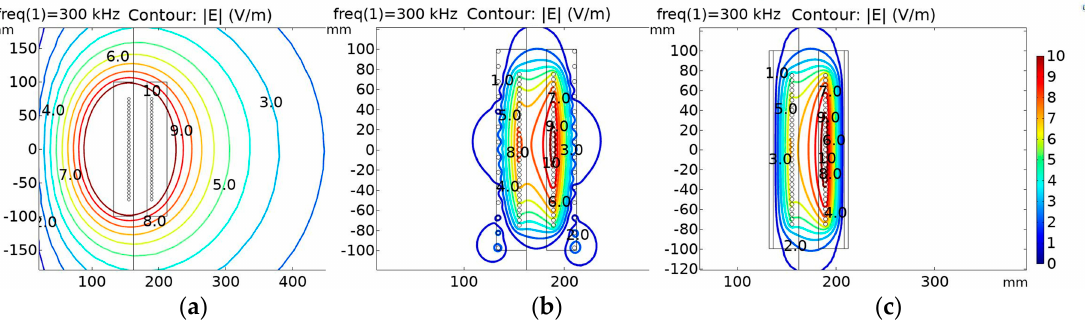
Figure 6. The distribution of electric field: ( a ) the system without shield; ( b ) the system with shielding coils; ( c ) the system with metallic plate as shield.